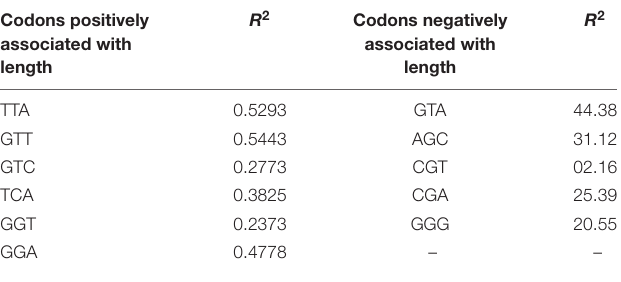
R 2 Codons negatively associated